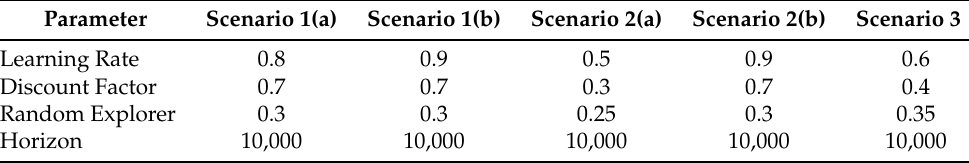
Table 1. Parameters values used in each training.